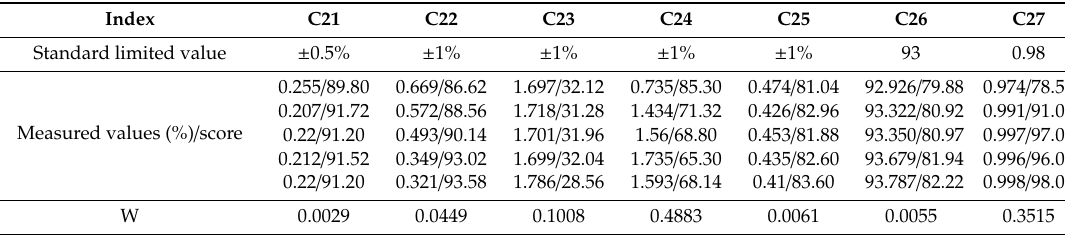
Table 7. Objective weight of the electrical performance.